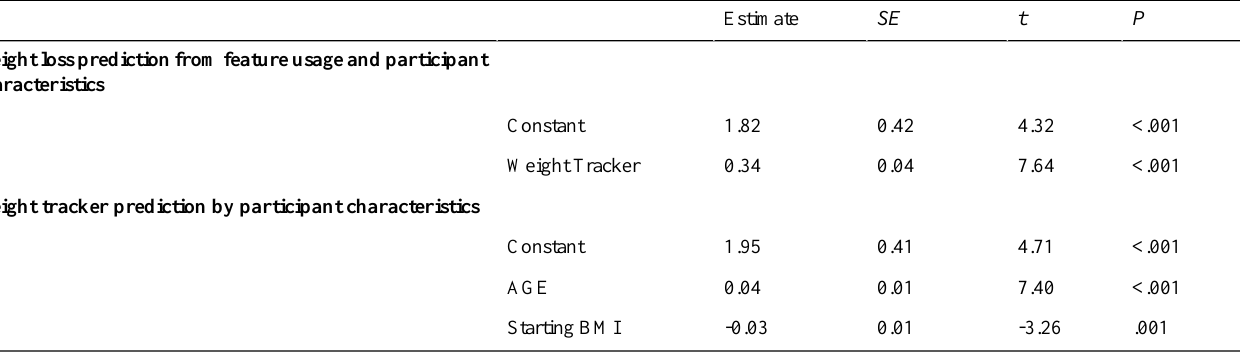
Table 4. Summary of parameter estimates for prediction of percent weight loss and use of the weight tracker (data from the supportive site and III starters